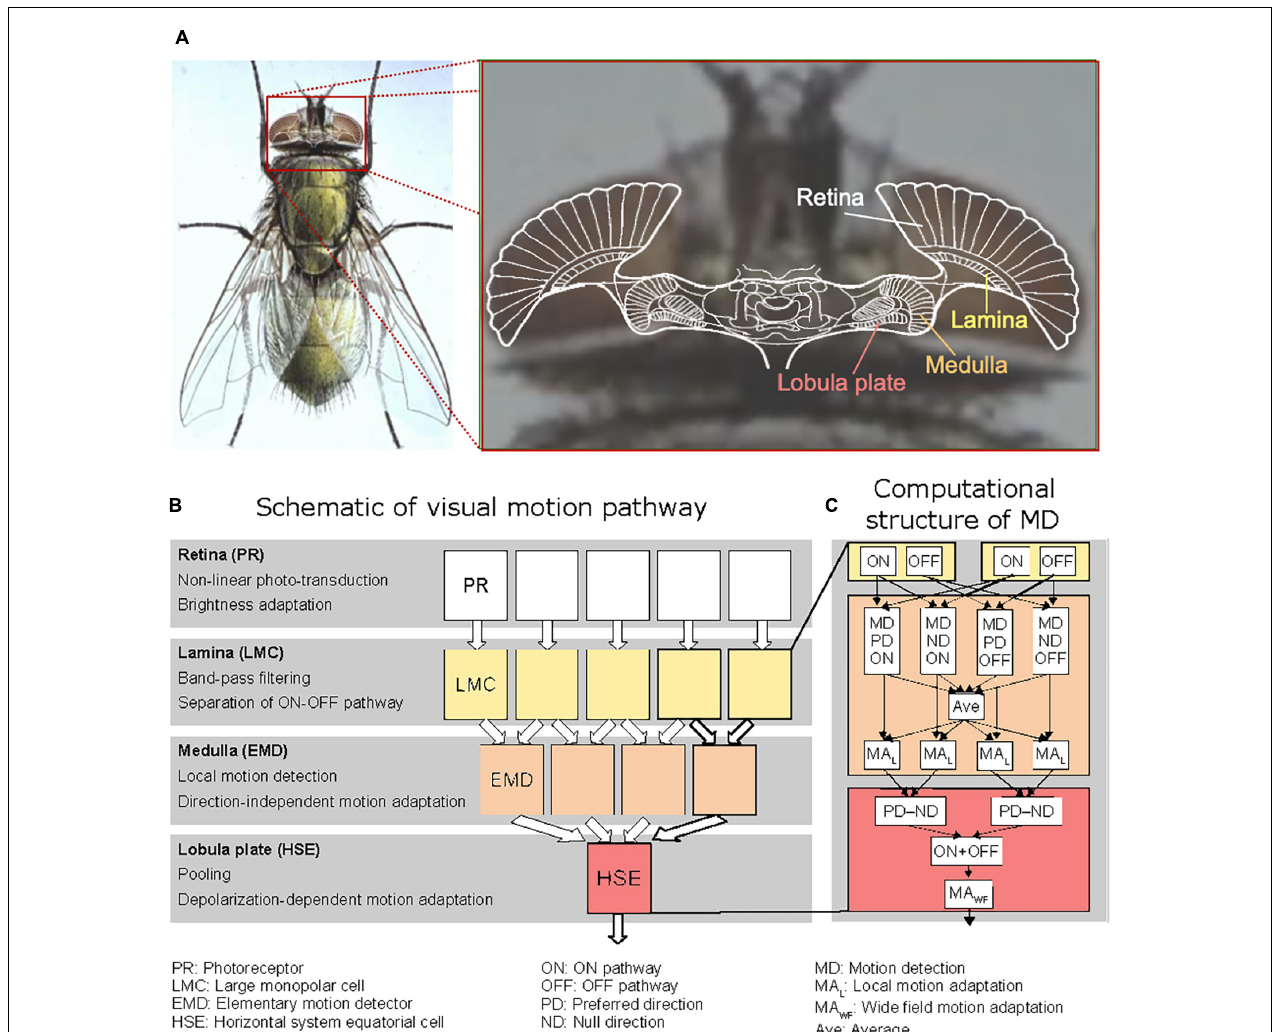
FIGURE 2 | Organization of the processing stages of the fly’s visual motion pathway. (A) Sketch of a horizontal section of the brain of the blowfly projected onto a photograph of its head, with the retina and the three main visual neuropiles labeled. The colors correspond to those used to mark the corresponding processing stages in the computational model shown in panels (B,C) . (B) Schematic illustration of the visual motion pathway with its consecutive processing stages and its retinotopic columnar organization (up to the level of the Lobula plate). The computations performed at the individual processing stages are briefly characterized at the left of the diagram. (C) Sketch of the different computations performed in two neighboring channels of the model Lamina and of the motion detection (MD) processing in the Medulla, as well as the computations performed at the HSE level. The non-linearly transformed photoreceptor signals are temporally band-pass filtered in each Lamina column by the Large Monopolar Cells (LMC), half-wave rectified and split into an ON and an OFF channel. The Lamina output signals are fed into a model of an elaborated elementary movement detector (EMD) of the correlation type. The signals are processed separately at the EMD stage for the ON and OFF channels as well as for preferred direction (PD) and null direction motion (ND), respectively. For motion adaptation, the outputs of the resulting four channels, shown here for horizontal motion, are averaged (AVE); the average also includes the signals of the corresponding four vertically oriented movement detecting elements (not shown) leading to a direction-independent signal representing the overall motion at the respective location in the visual field. Local motion adaptation (MA L ) is accomplished by dividing the outputs of the movement detection channels by the averaged motion signal after low-pass filtering. The movement detector channel outputs are then summated according to their respective sign (PD positive, ND negative) by the model HSE-cell. For the details of the different computational steps, see Materials and